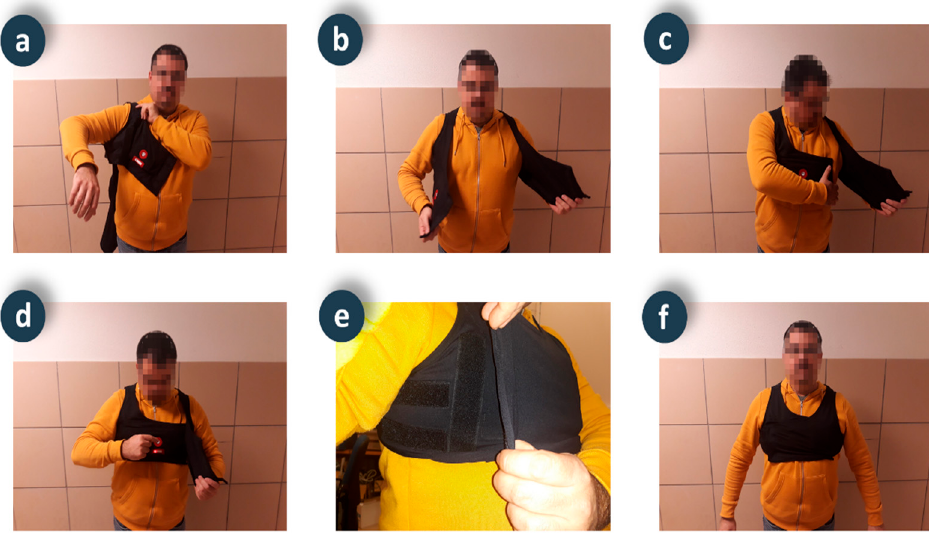
Figure 6. Sequence of the smart vest placement and activation process.